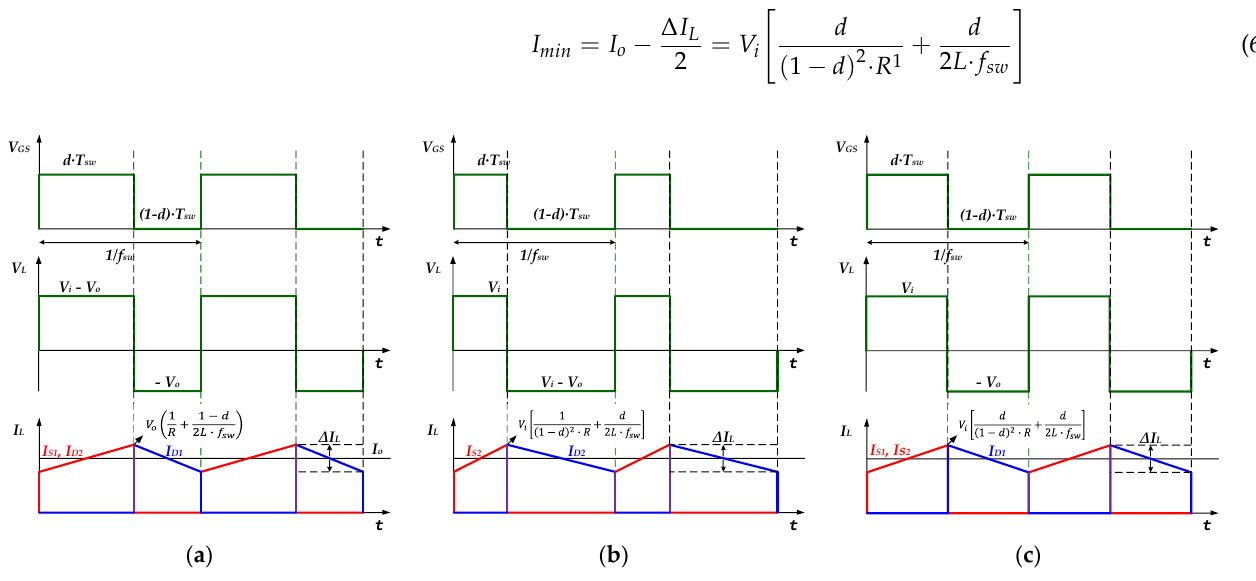
Figure 5. Switch and diode current of the proposed TSBB converter: ( a ) Buck; ( b ) Boost; ( c ) Buck-boost.